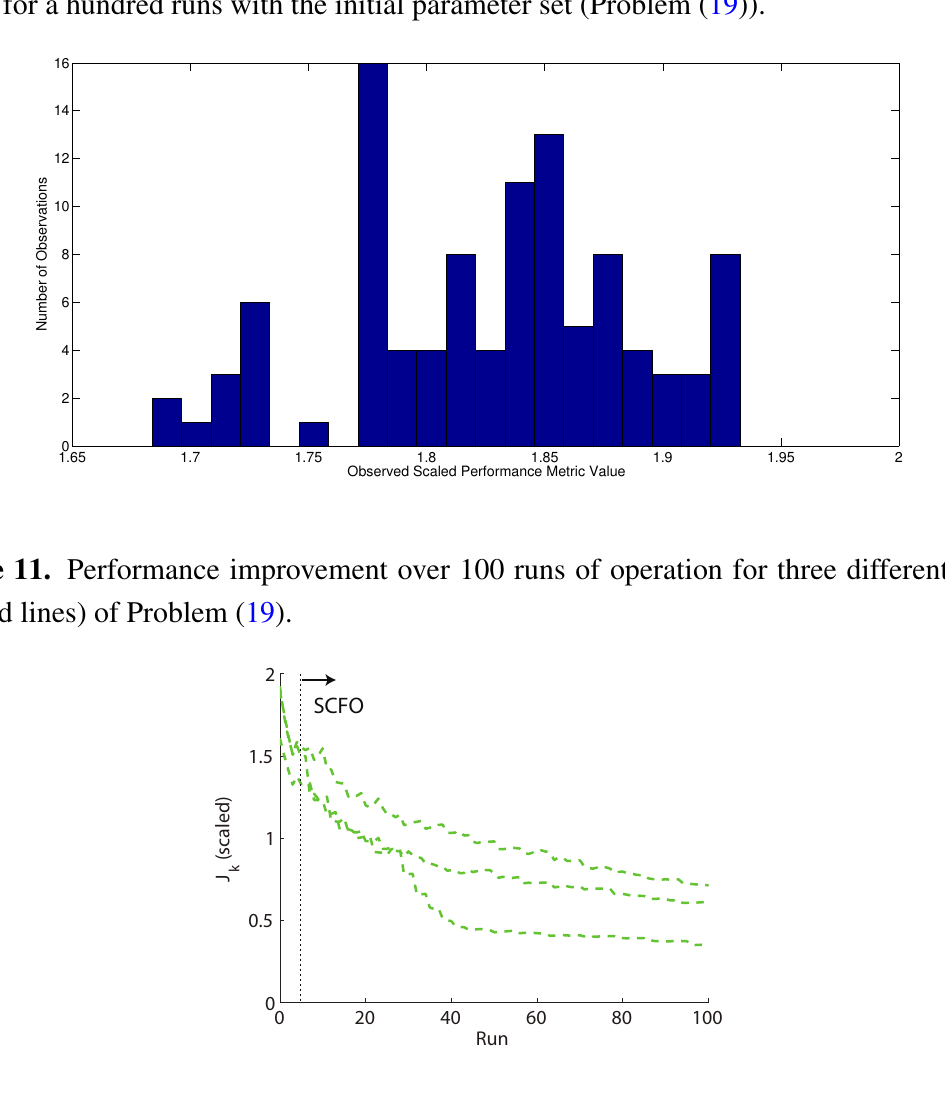
Figure 10. A twenty-bin histogram representation of the observed scaled performance metric values for a hundred runs with the initial parameter set (Problem (19)).